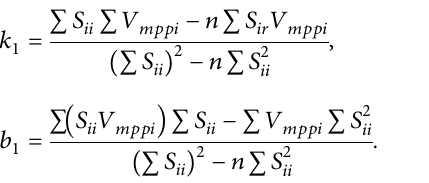
mpp and T under different